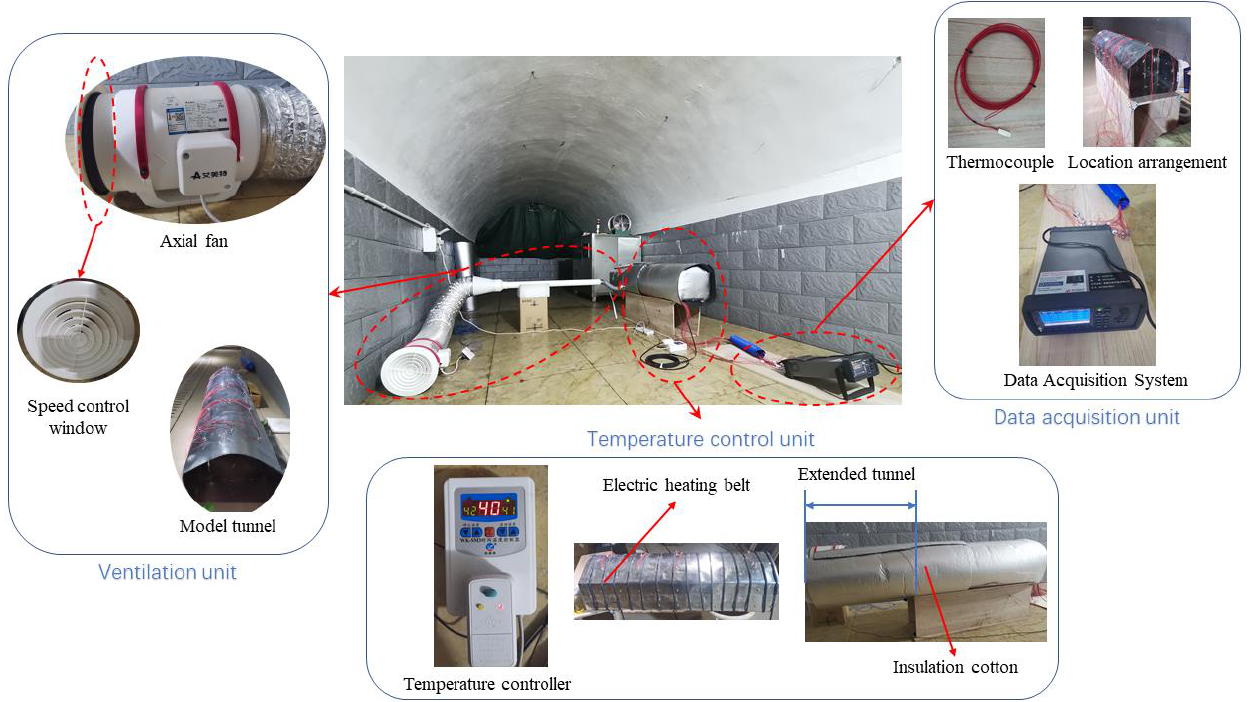
Figure 2. Scale model test platform for coupled cooling of ventilation and partial thermal insulation.